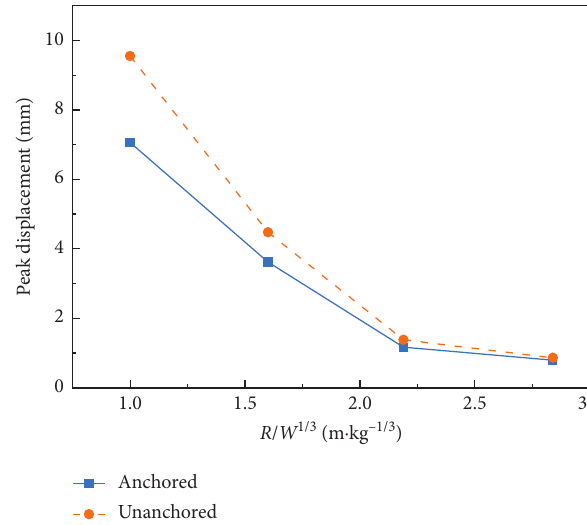
Figure 9: Relationship between peak displacement and scaled